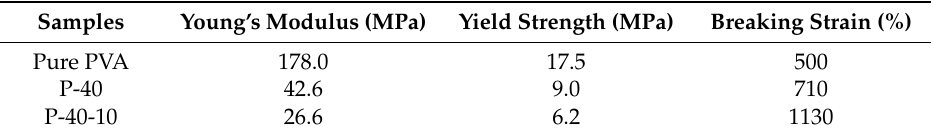
Table 2. Mechanical properties of the films. Figure 3. ( a ) Variation of loss tangent with frequency for P-40, P-40-5, P-40-10, and P-40-15. ( b ) Stress- strain curves of pure PVA, P-40, and P-40-10 films (insets show photographs of the films) recorded at room temperature.